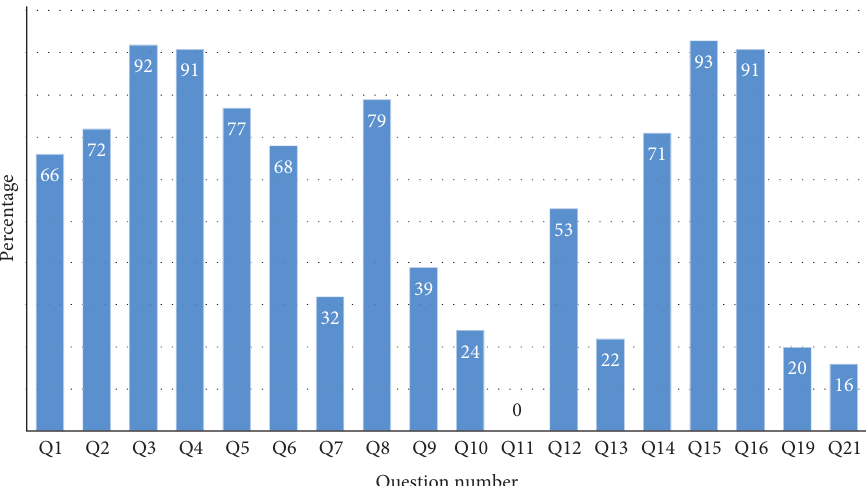
Figure 1: Percent of “yes” responses on binary questions of questionnaire given in Table 2 (Annex